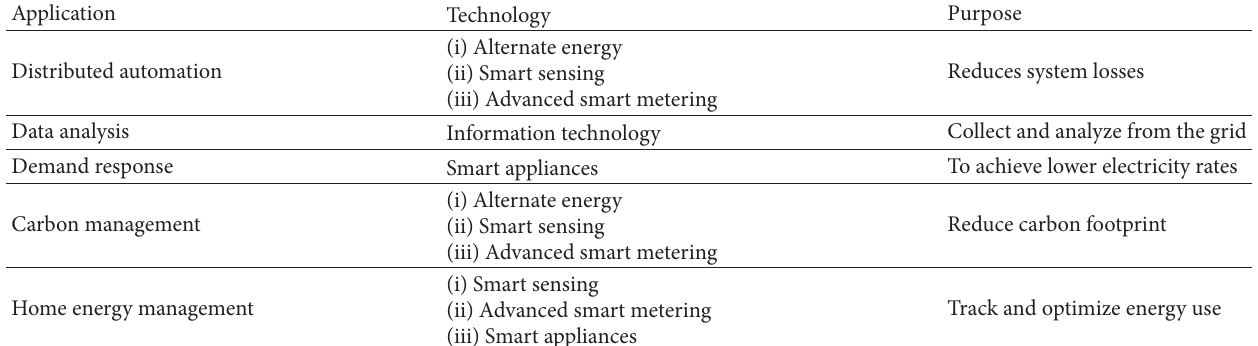
Table 5: Smart grid technologies, applications, and purposes